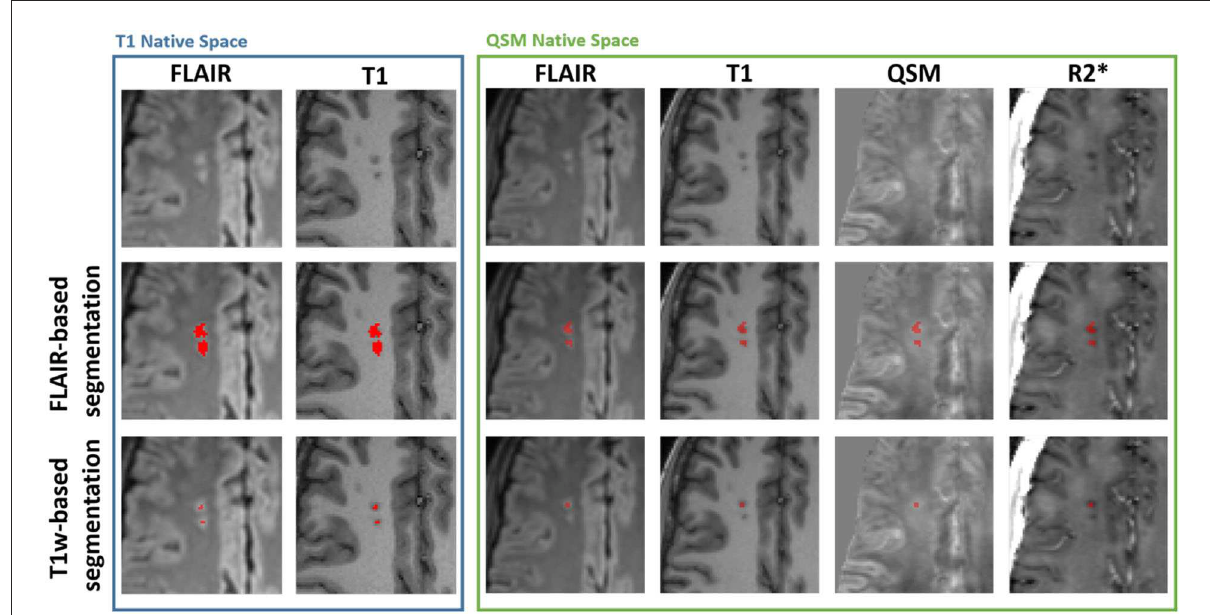
FIGURE1 Example silent cerebral infarct segmentations. Blue Box: Axial view of two silent cerebral infarcts (SCI) segmented in a representative patient with sickle cell anemia (SCA) overlaid on FLAIR and T1-weighted images in the native T1w space. The example SCI appear hyperintense on FLAIR images and hypointense on T1-weighted images. The application of a more stringent T1w-based maximum intensity threshold (bottom) reduces the volume of the segmented SCI lesions relative to the standard FLAIR-based segmentation (middle). Green Box: Axial view of the same SCI after interpolation into the native quantitative susceptibility mapping (QSM) space, overlaid over FLAIR, T1w, QSM and R2* images. The SCI appear bright on QSM and dark on R2* maps relative to normal appearing white matter. Note that the coregistration of the lesions into the QSM space results in the lower SCI segmentation appearing in the adjacent